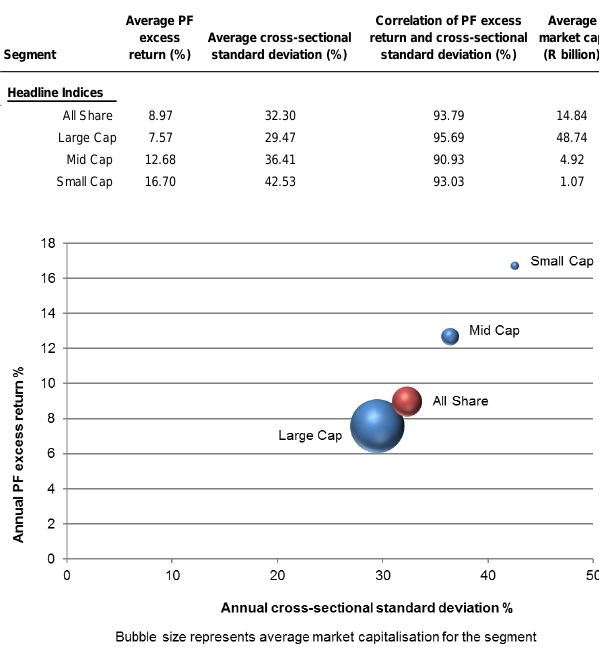
Table 6: Summary statistics for various JSE segments, 1995-2014